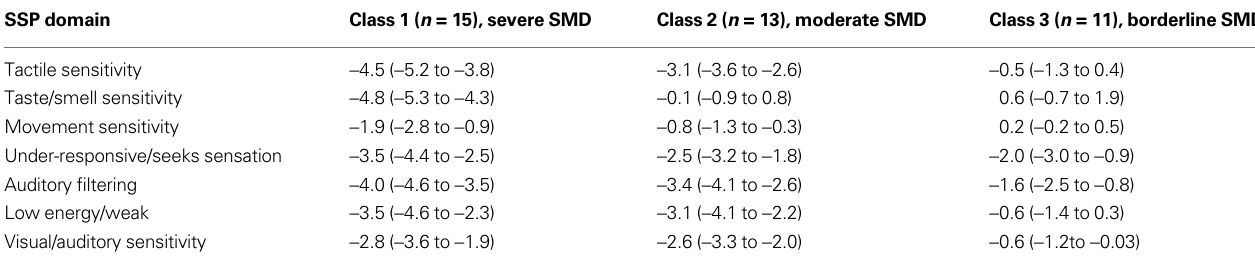
Table 3 | Latent class analysis: mean SSP z -scores (95% CI) by SMD class. SSP domain